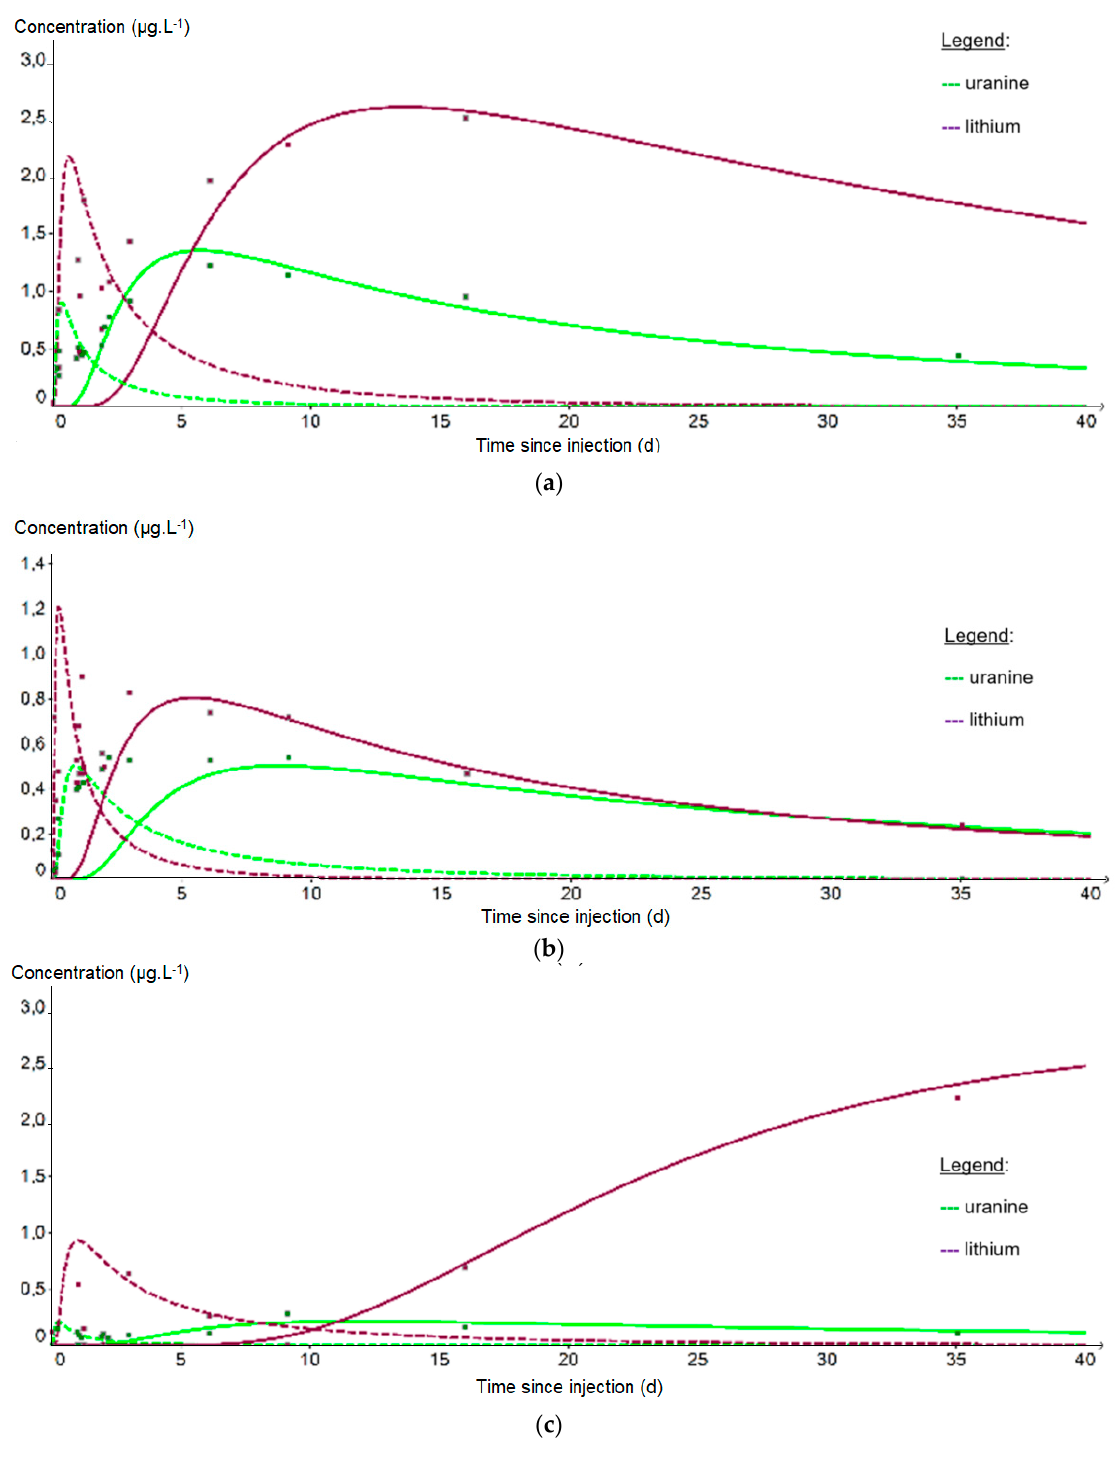
Figure 11. Evolution of the tracer concentrations at the downstream piezometers: ( a ) PZ3; ( b ) PZ4; ( c ) PZ5. The curves correspond to the fit of the first peak for the dashed curve and of the second peak for the solid curve; the purple curve represents lithium and the green curve uranine.